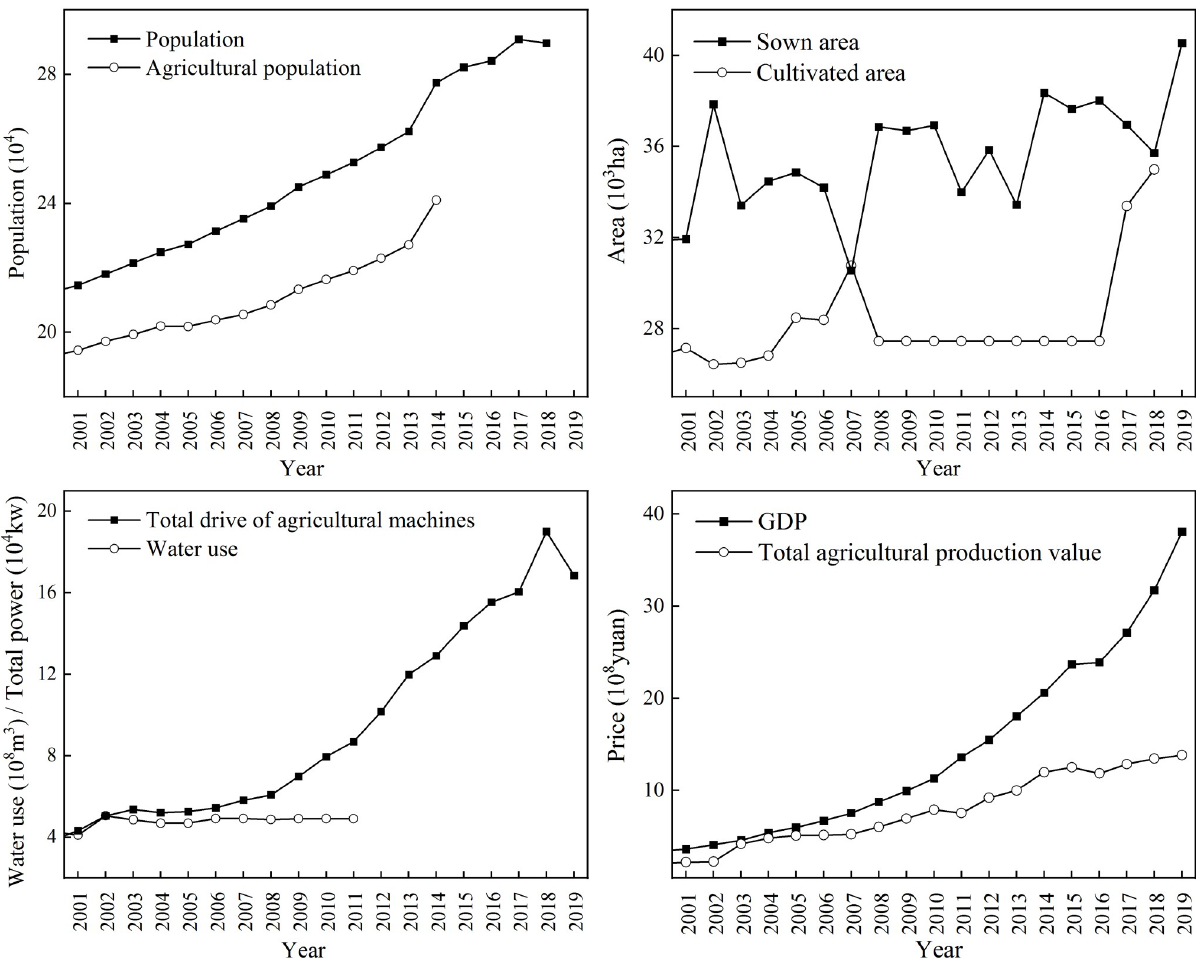
Fig 11. Social and economic changes in Yutian County, located within the middle reaches of the Keriya River from 2000 to 2019, including population (a), agricultural population (a), sown area (b), cultivated area (b), total drive of agricultural machines (c), water use (c), GDP (d), and total agricultural production